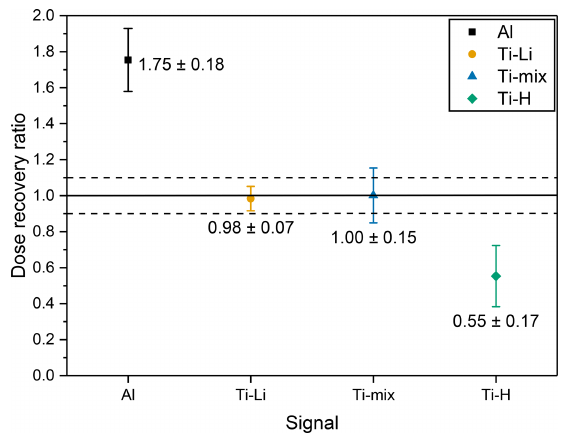
Figure 5. Comparison of ESR Al and Ti-Li residual doses with linear